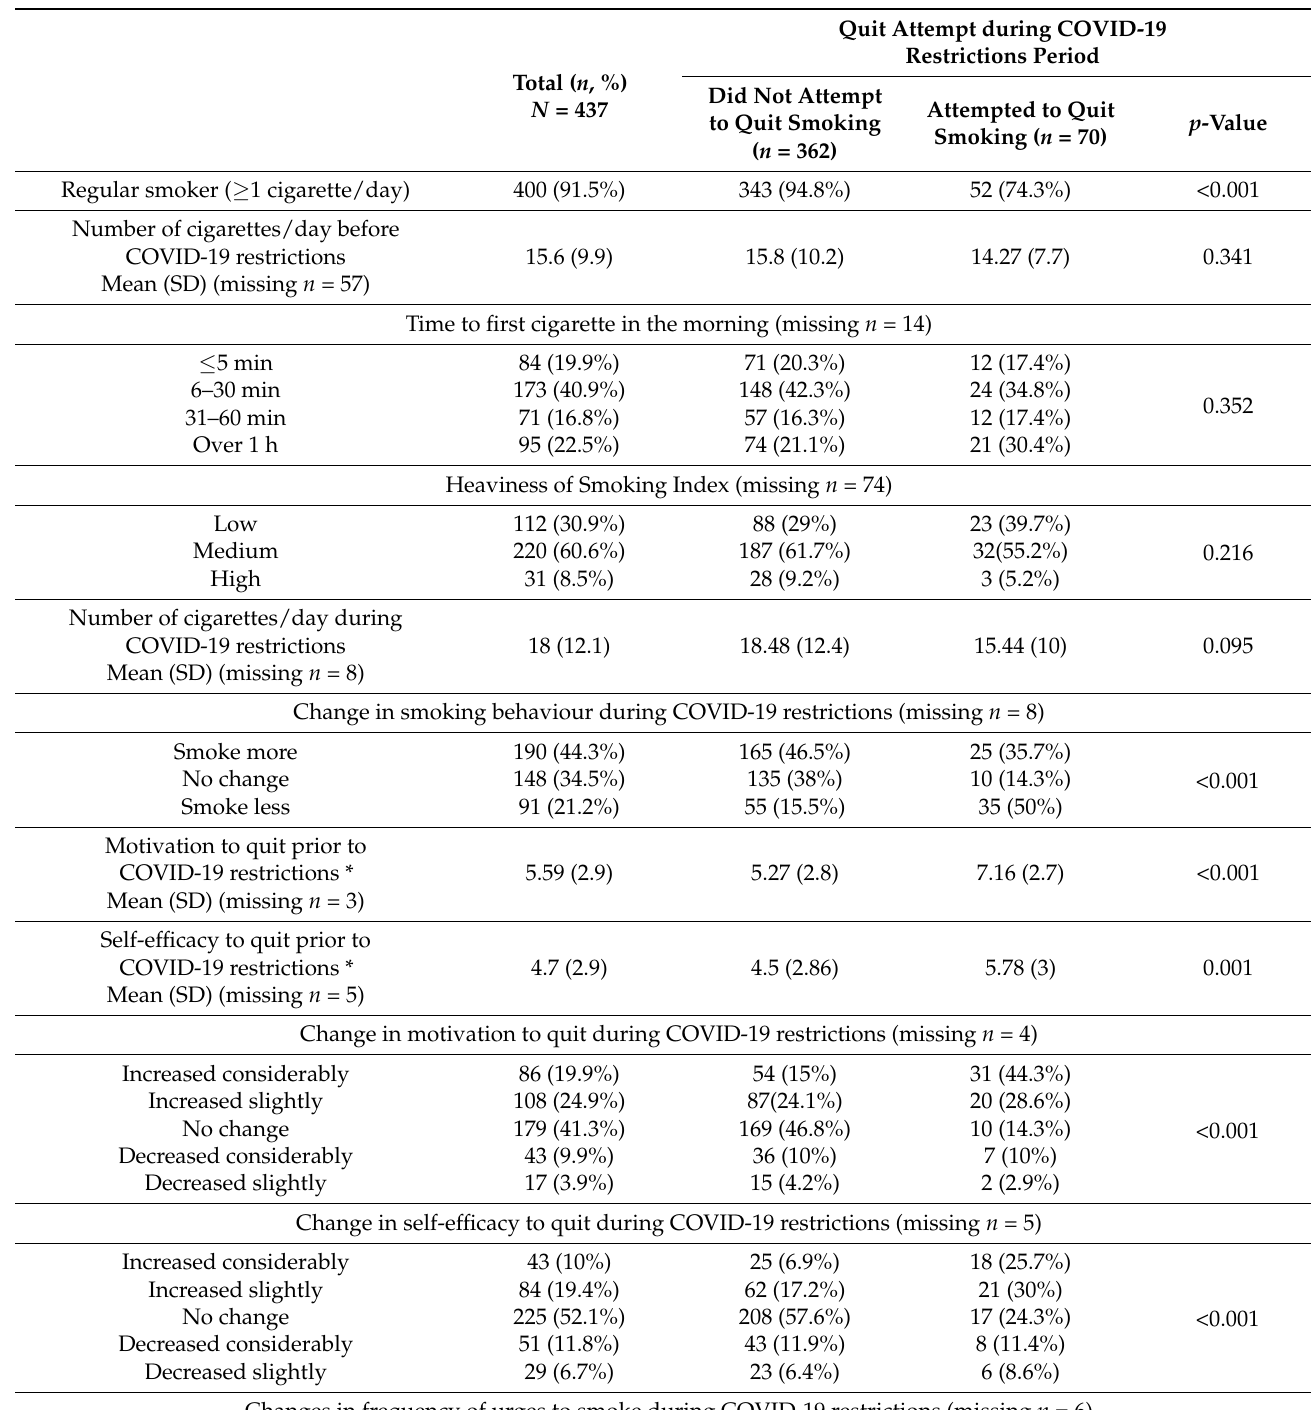
Table 3. Smoking patterns among current smokers ( N = 437), Israel,